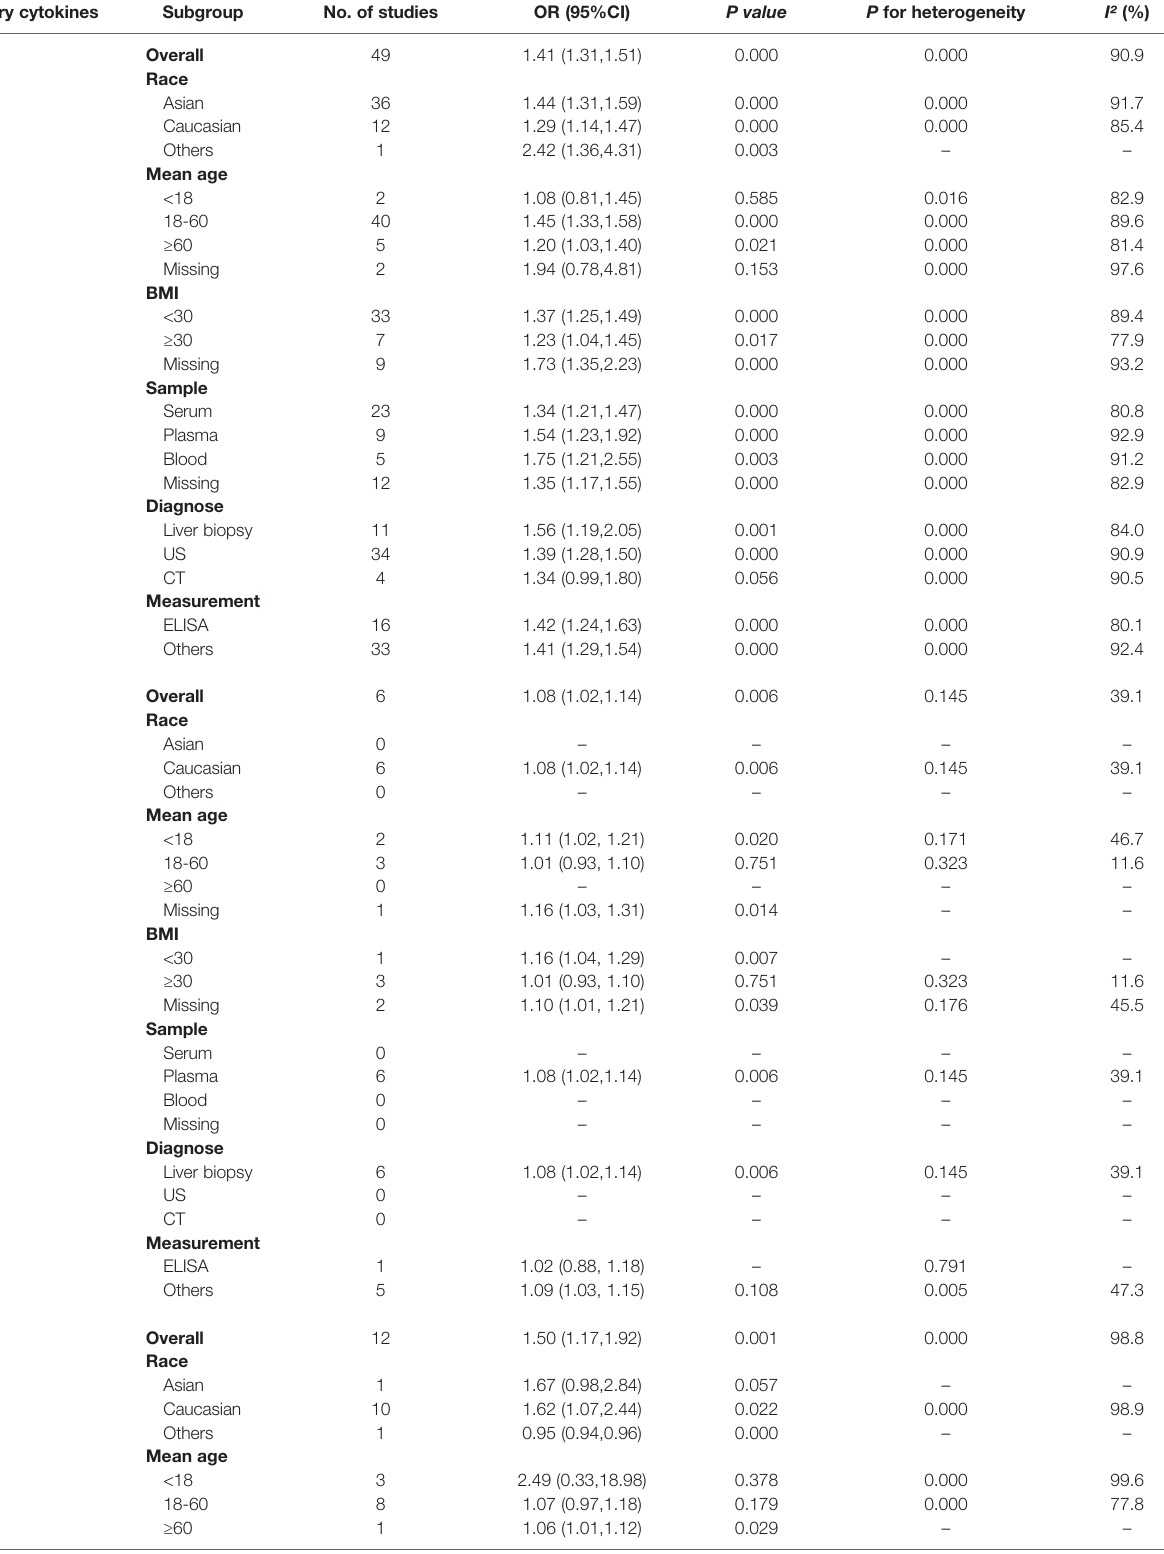
TABLE 2 | Subgroup analyses of the association between in fl ammatory cytokines and NAFLD. In fl ammatory